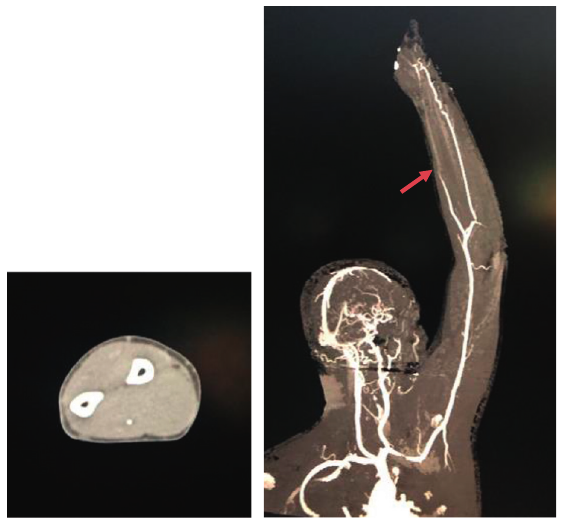
Figure 2: IV contrasted CT scan showing occlusion of the left radial artery at the level of the midforearm with retrograde filling at the level of the left